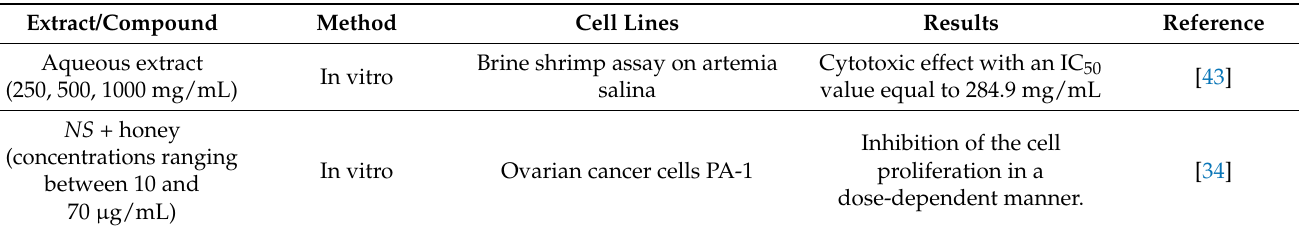
Table 3. Summary of the anticancer activities of NS